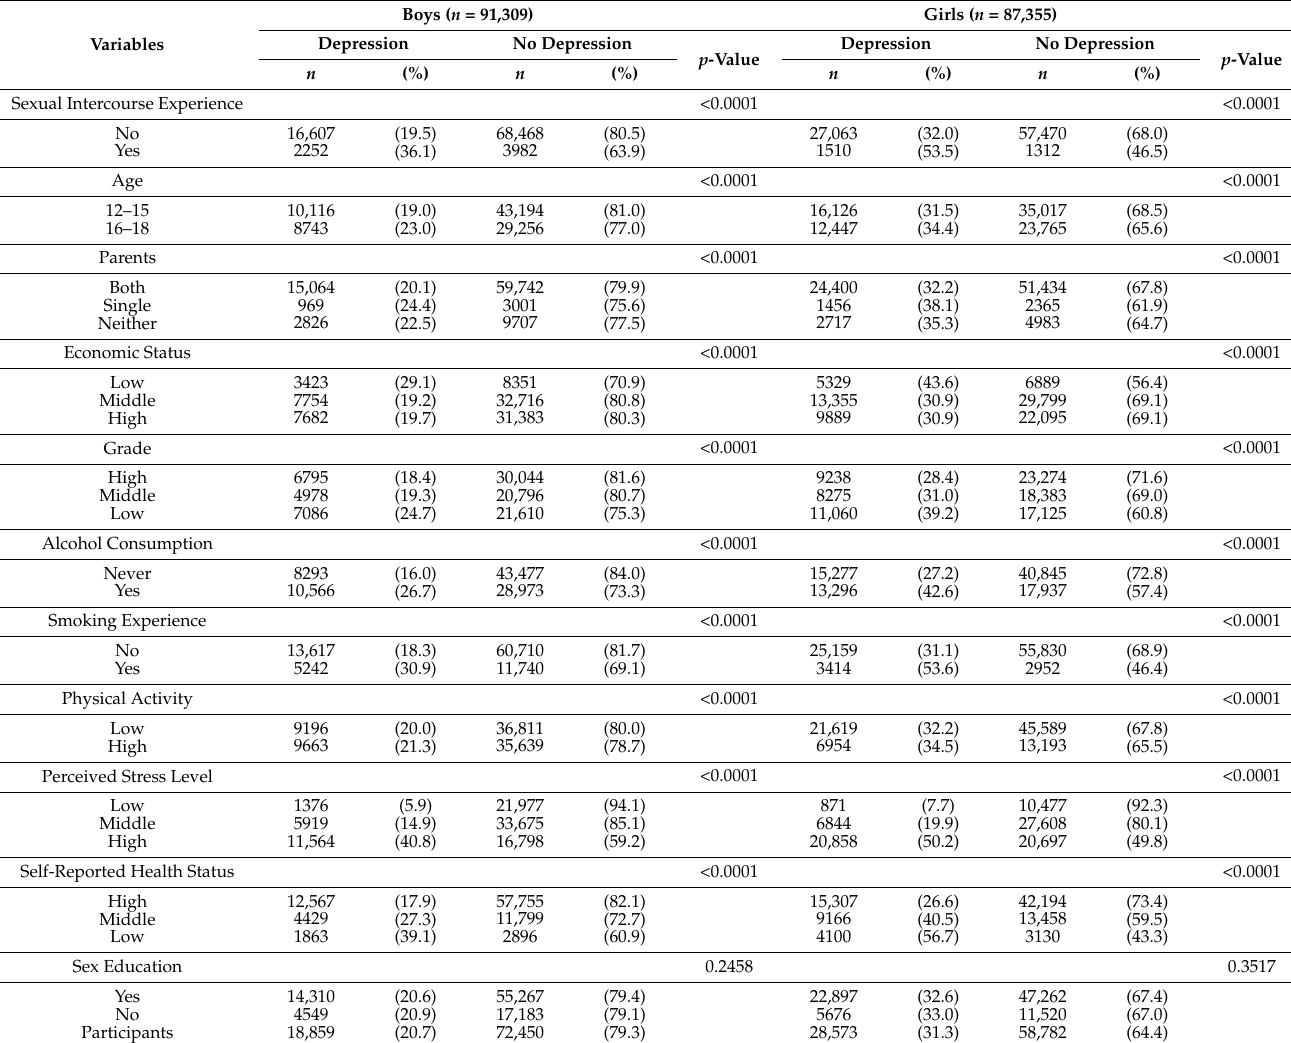
Table 1. Socioeconomic and health-related characteristics according to the presence/absence of